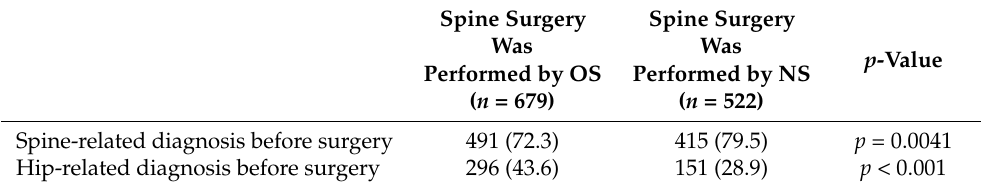
Spine Surgery Spine Surgery Was Was p -Value Performed by NS Performed by OS ( n = 522) ( n = 679) 296 (43.6) 151 (28.9) p <